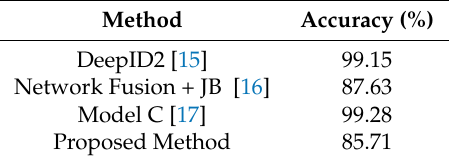
Table 3. Unconstrained environment. DeepID2: Deep IDentification-verification; JB: Joint